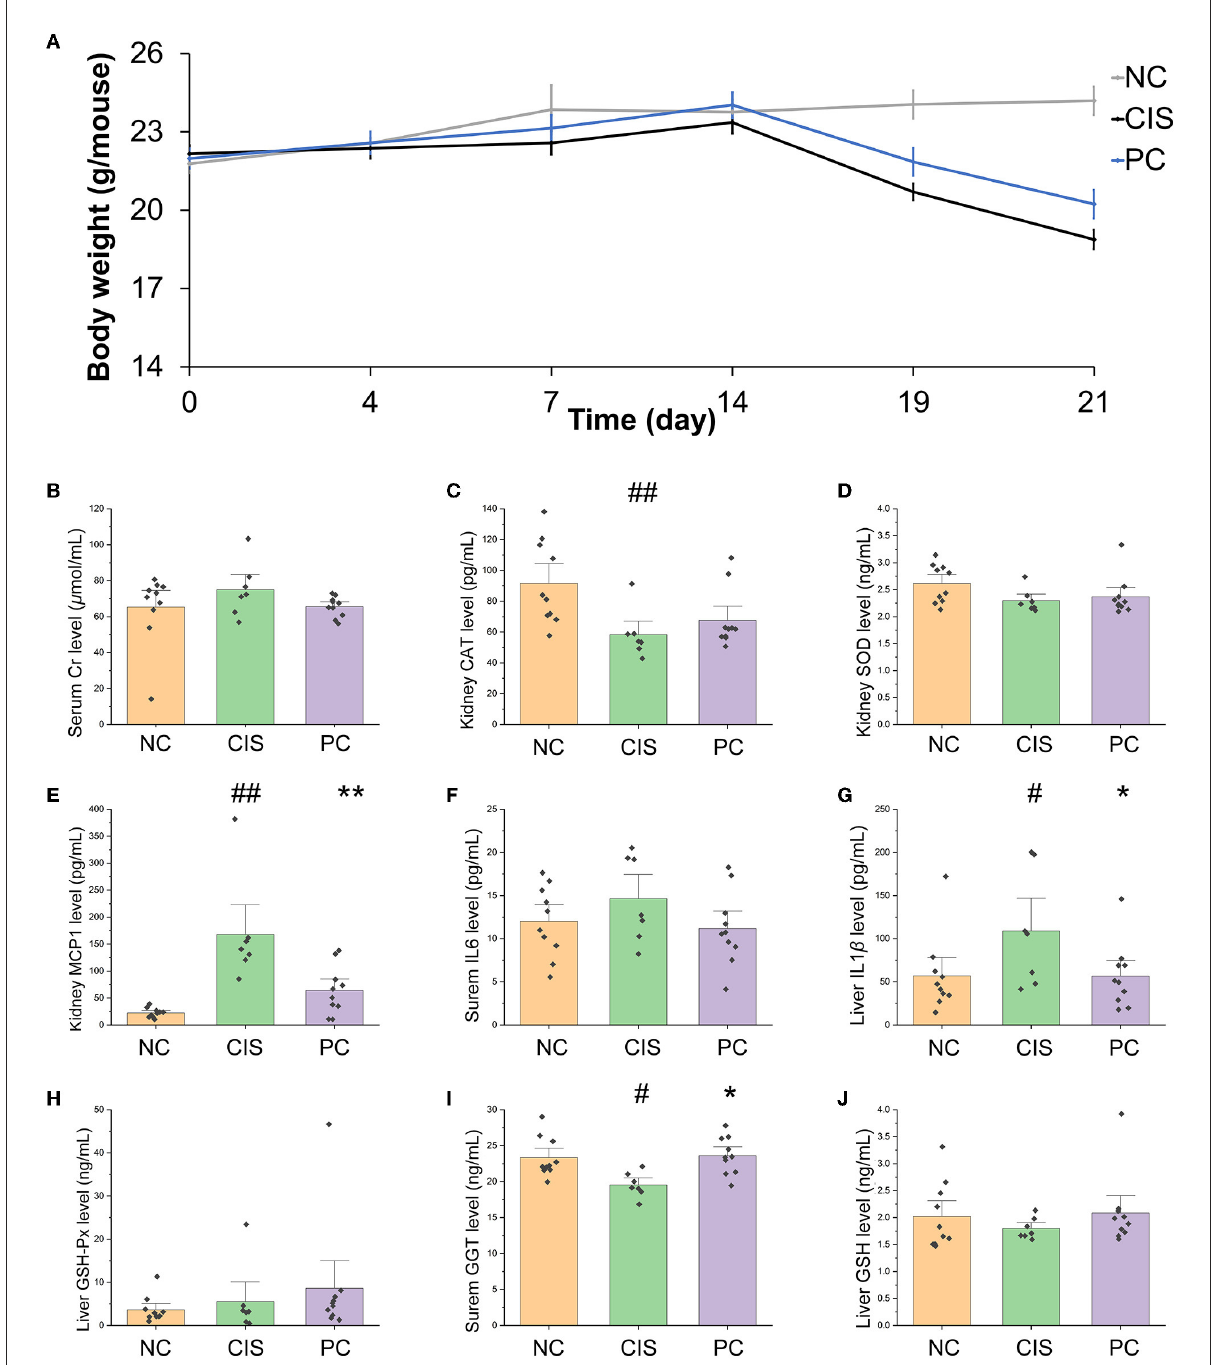
FIGURE1 Body weight and biochemical parameters of blood, kidney, and liver in mice. (A) Before cisplatin intervention, there were no significant differences in body weight among the three groups ( p > 0.05). Cisplatin intervention significantly decreased body weight compared with the NC group on the 19th and 21st day ( p < 0.01). (B) serum Cr level; (C) kidney CAT level; (D) kidney SOD level; (E) kidney MCP1 level; (F) serum IL6 level; (G) liver IL1 β level; (H) liver GSH-Px level; (I) liver GGT level; (J) liver GSH level. The marker on PC column indicates the significant difference of PC vs. CIS (* p < 0.05, ** p < 0.01); the marker on CIS column indicates the significant difference of CIS vs. NC (# p < 0.05, ## p < 0.01). NC, normal control; CIS, cisplatin; PC, cisplatin with